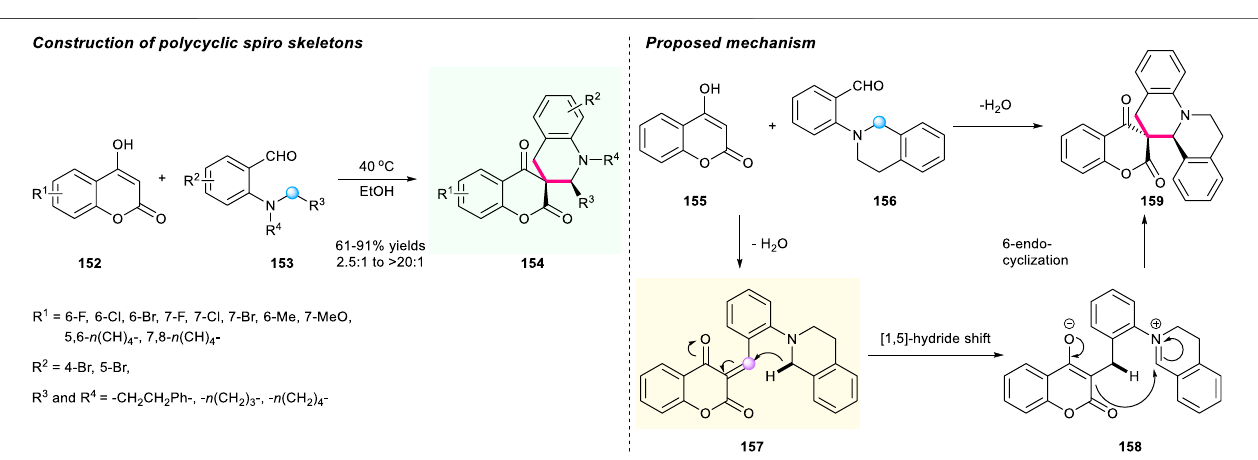
Frontiers in Chemistry |